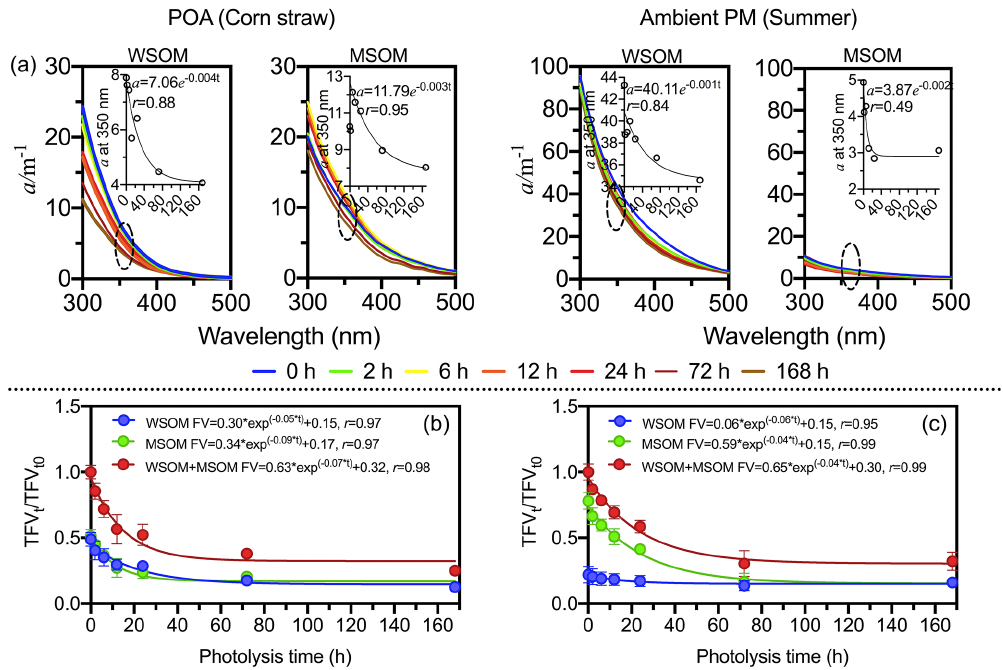
Figure 2. Changes in absorption coefficient and fluorescence volume in the photodegradation process. (a) Absorption coefficient. The scat- terplot shows the absorption coefficient at 350nm. Panels (b) and (c) show the attenuation curve of fluorescence volume in POA (except for the wood sample) and ambient PM,